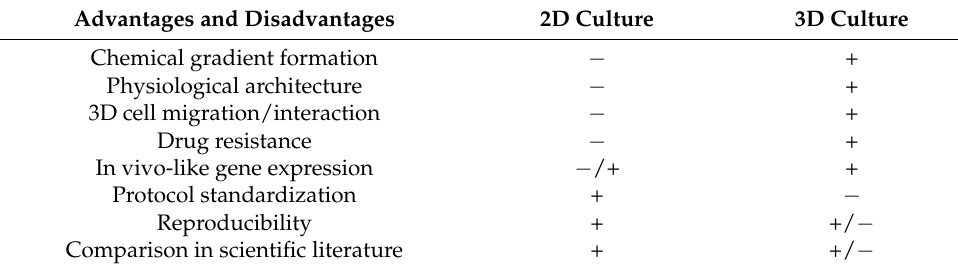
Table 3. Main differences between 2D and 3D